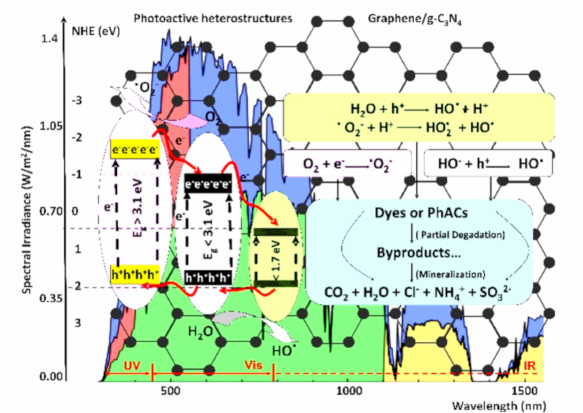
Figure 1. Photoactive heterostructures and the corresponding photocatalytic